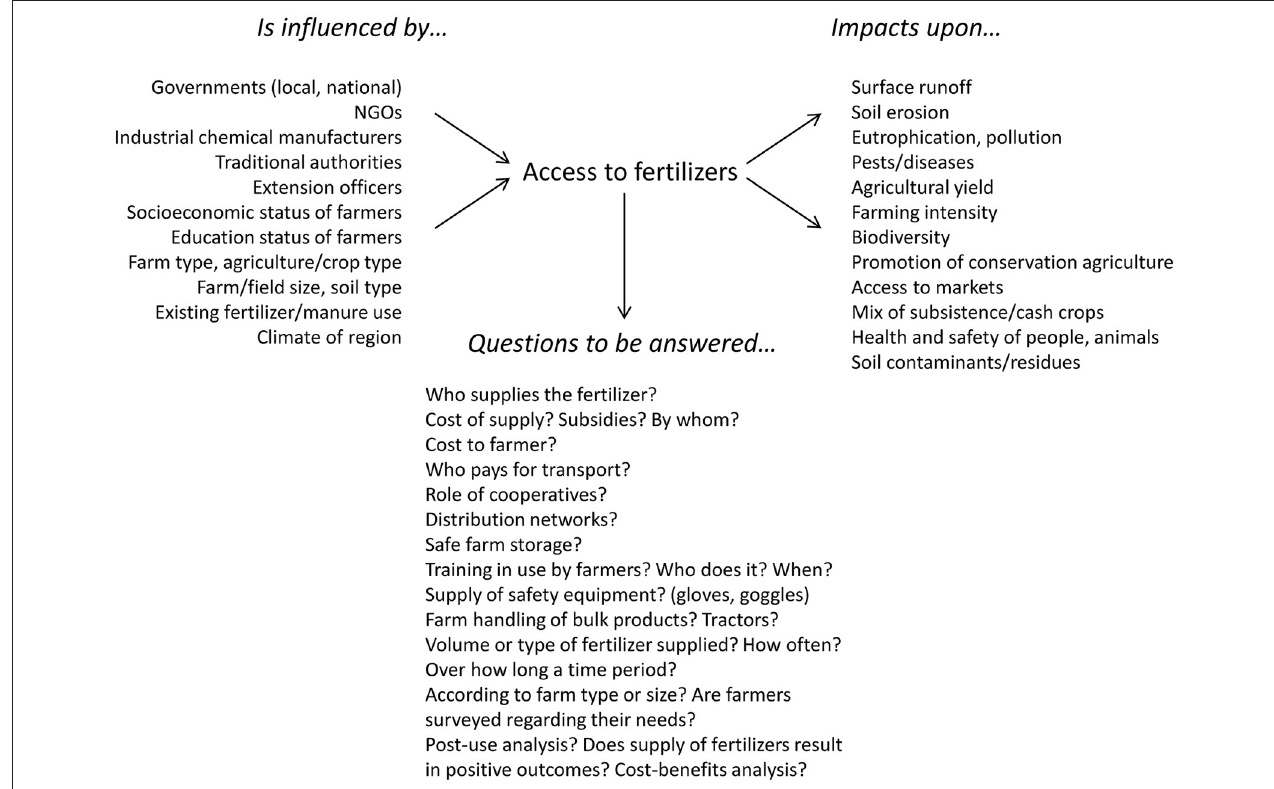
FIGURE 2 | Example of how a simple intervention such as access to fertilizer (Love et al., 2006) links to wider aspects of nexus intersections in the physical and human